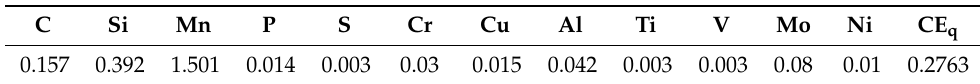
Table 1. Chemical composition of AH36 steel (w t